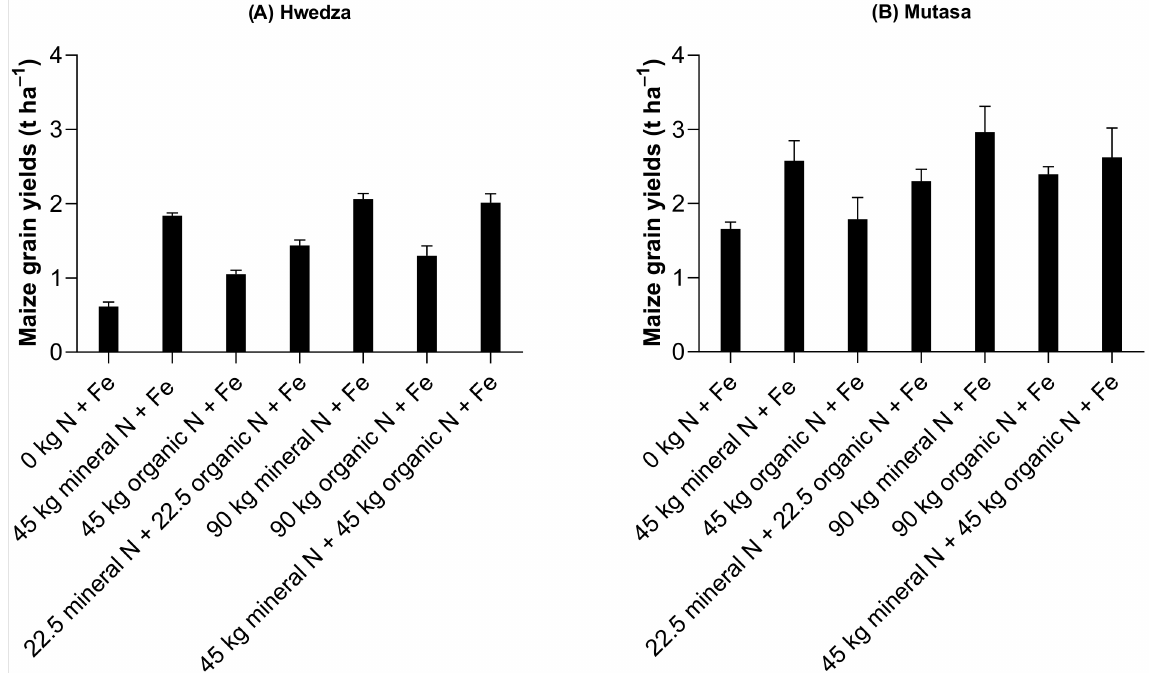
Figure 2. Mean maize grain yields ( ± standard error of means, SEM) in ( A ) Hwedza and ( B )